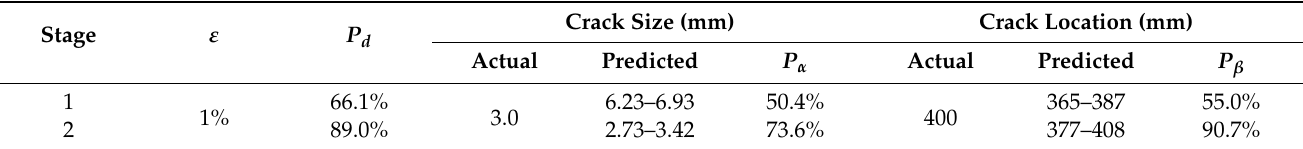
Table 3. Results summary for Case